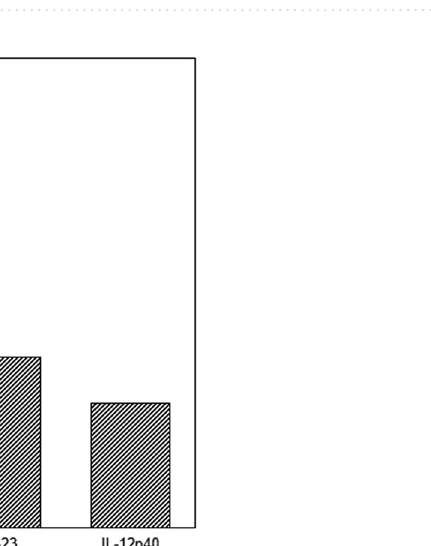
Figure 2. Standardized biplot generated using PLS-DA analysis visualizing the multivariate cytokines profiles of 78 female RA patients and 51 healthy controls in two-dimensional subspace based on their individual scores on Latent Variable 1 and Latent Variable 2.